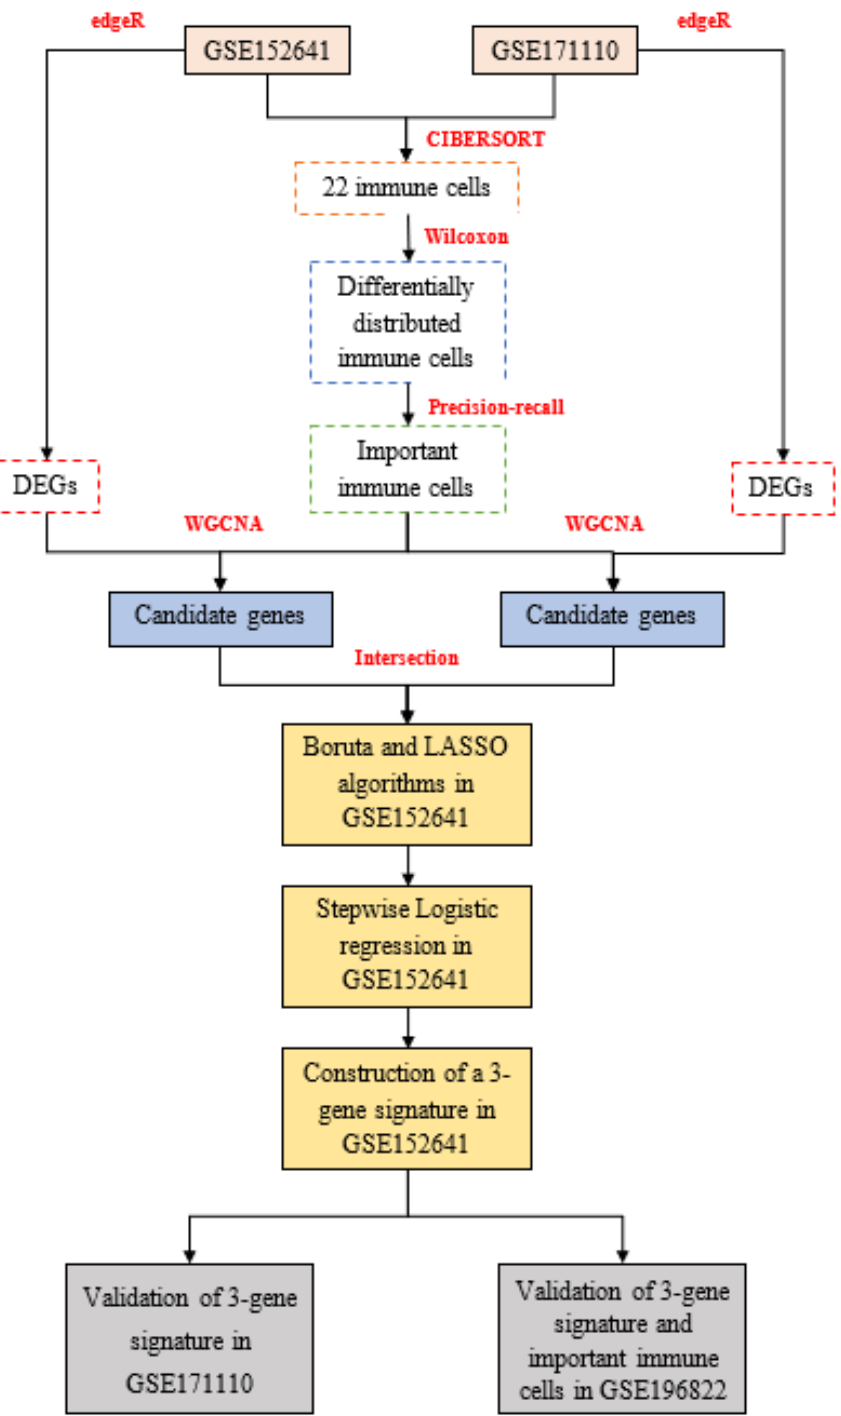
Figure 1. The workflow of this study: edgeR: empirical analysis of digital gene expression in R, CIBERSORT: cell-type identification by estimating relative subsets of RNA transcripts, DEGs: differentially expressed genes, WGCNA: weighted gene co-expression network analysis, LASSO: least absolute shrinkage and selection operator.